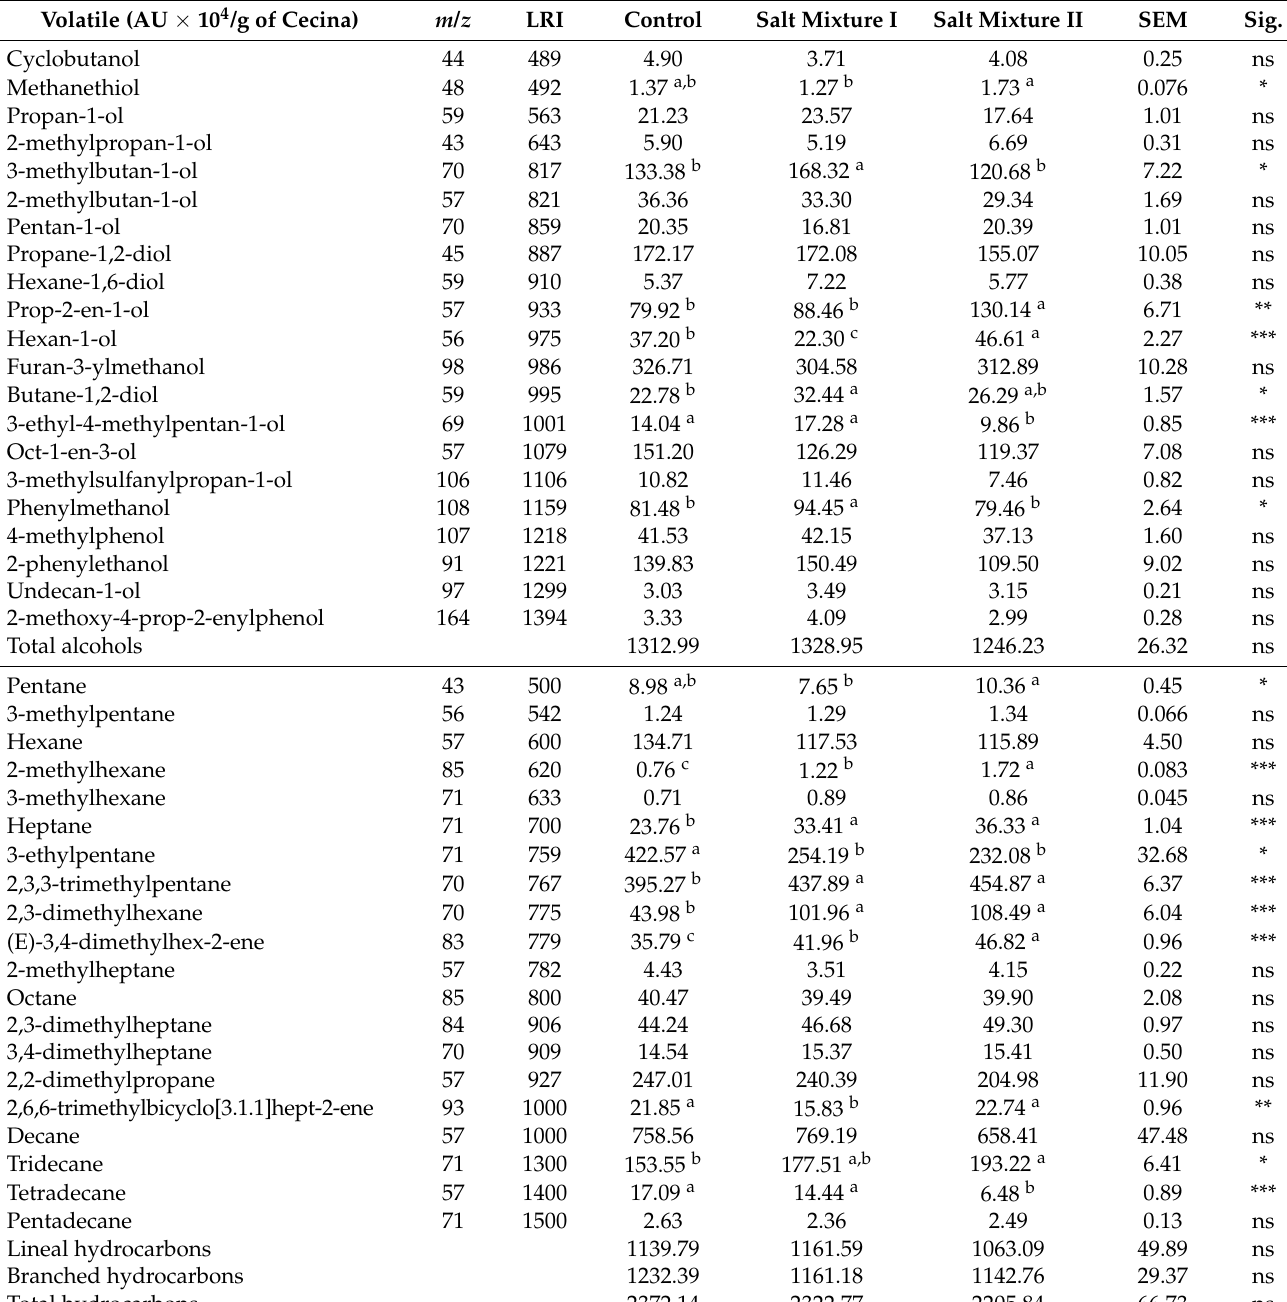
Table 5. Effect of NaCl replacement by other chloride salts on alcohols, and hydrocarbons of dry-cured deer “cecina”. Volatile (AU × 10 4 /g of